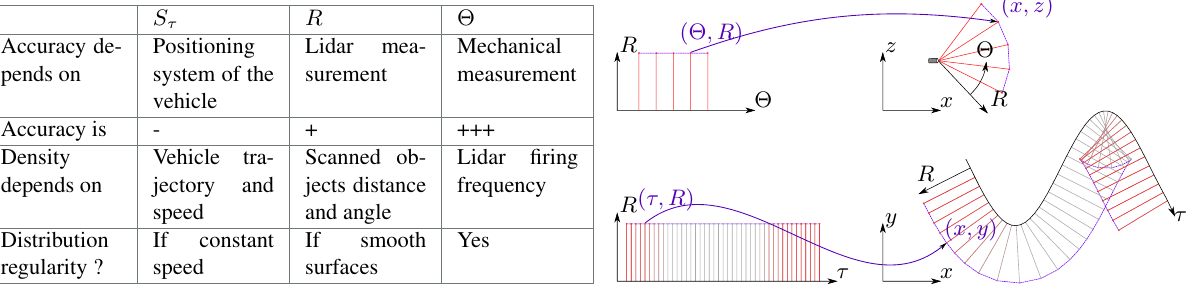
Figure 5: Scan order is kept when passing from (Θ , R ) to ( x, z ) . This is not the case when passing from ( τ, R ) to ( x, y ) .